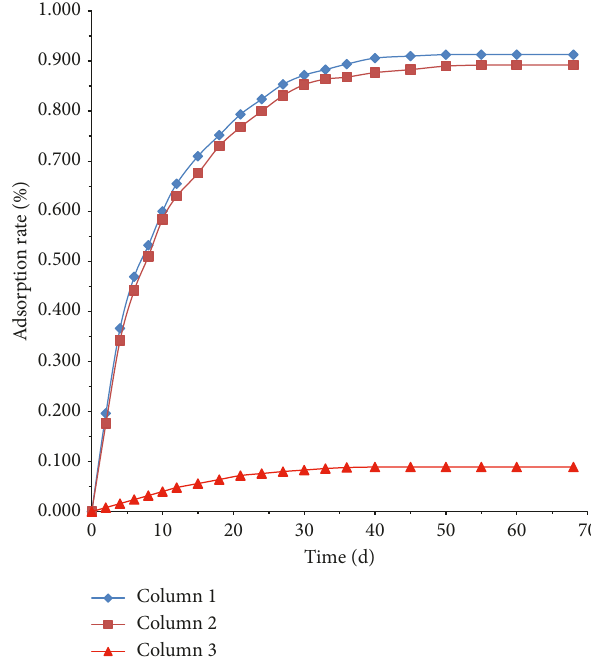
Figure 5: Changes in adsorption rate as function of time.